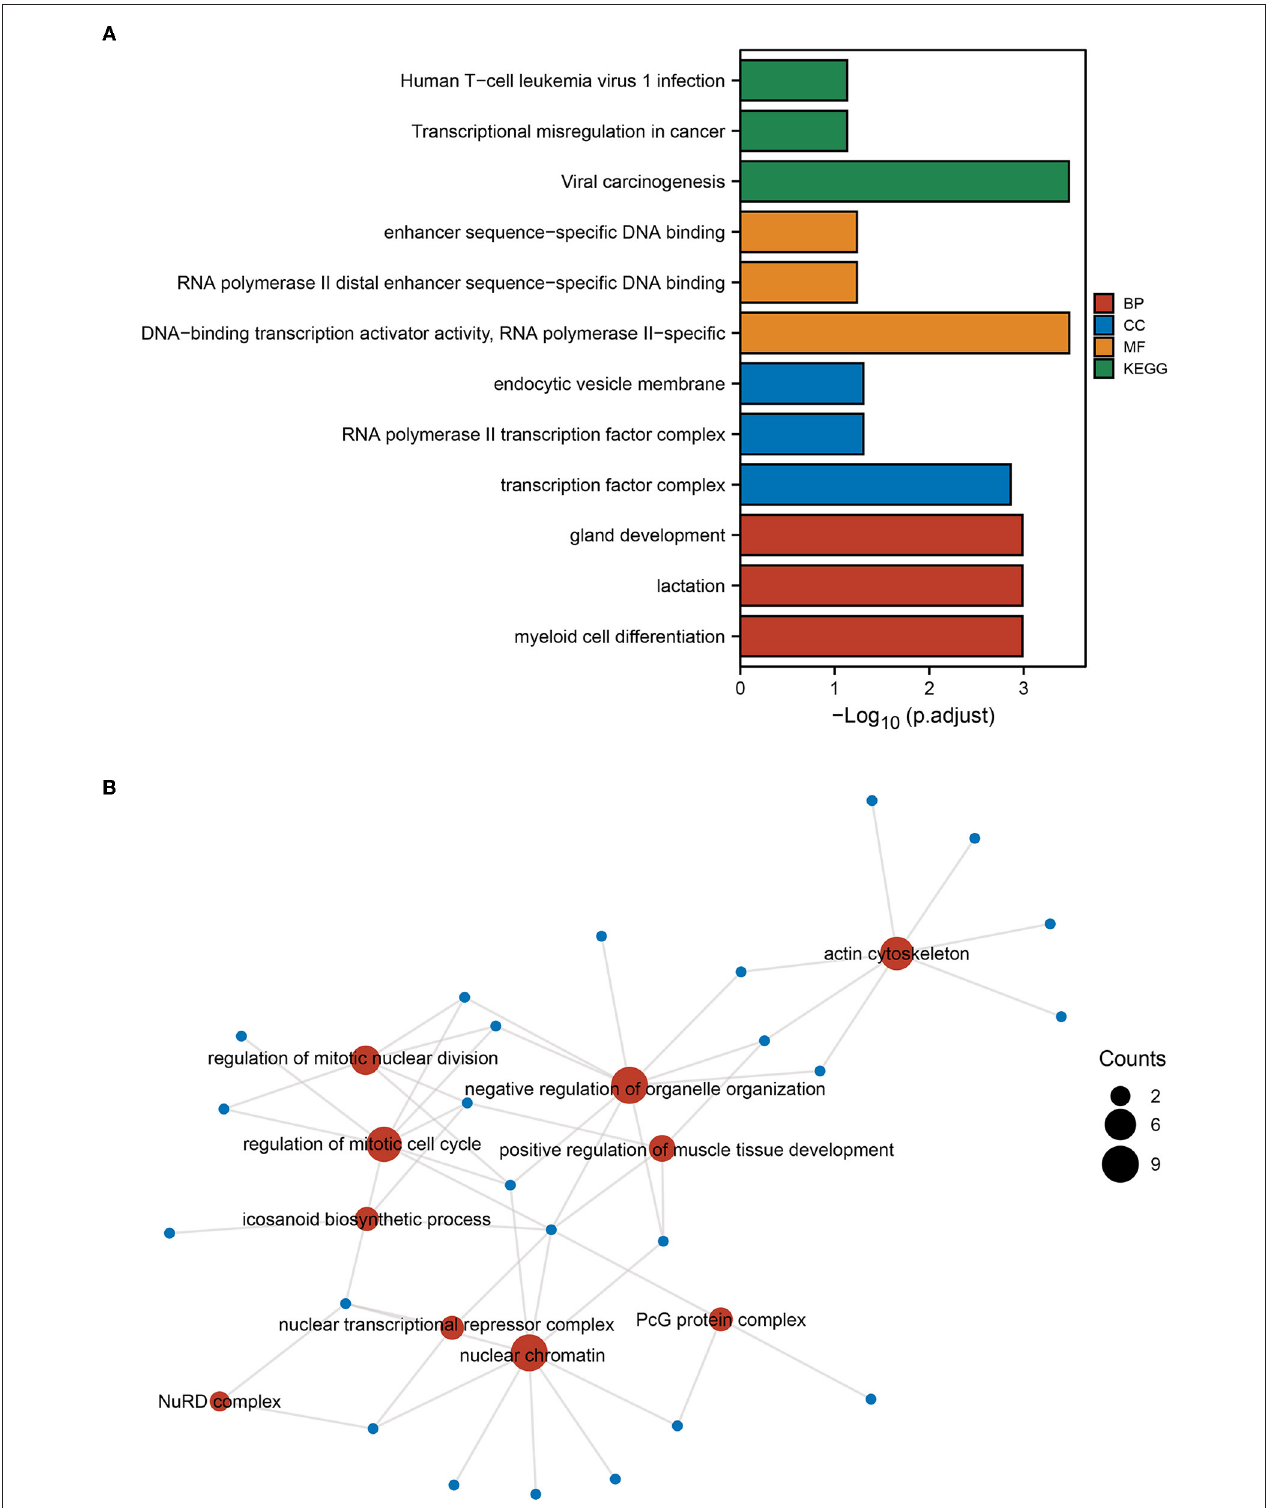
FIGURE 3 | GO and KEGG enrichment analysis. (A) Gene Ontology (GO) and Kyoto Encyclopedia of Genes and Genomes (KEGG) enrichment analysis of genes from PPI subnetwork 1 and subnetwork 2 gene. (B) Based on the results of the single-cell regulatory network inference and clustering (SCENIC) analysis, GO functional enrichment analysis was performed for genes downstream of the transcription factor REL. The size of the dot indicates the number of genes.